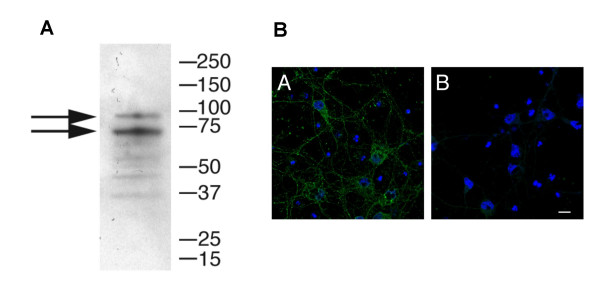
(A) Human brain soluble extracts (40 ug per lane) were separated on 4–20% SDS-PAGE gels and blotted using a goat polyclonal antibody to the C-terminus of IFT74 (Imgenex, anti-CMG1) at a final antibody concentration of 0.5 mg mL-1. Two major bands at ~90 kDa and ~70 kDa were identified which were blocked by pre-absorption of the antibody with the immunizing peptide (data not shown), indicating specificity. (B) A. Immunofluorescent staining of primary rat cortical neurons with the same antibody showed localization of IFT74 to vesicles in the cell body and along the neuronal processes. B. Secondary antibody alone gave no signal using consistent gain and offset settings.